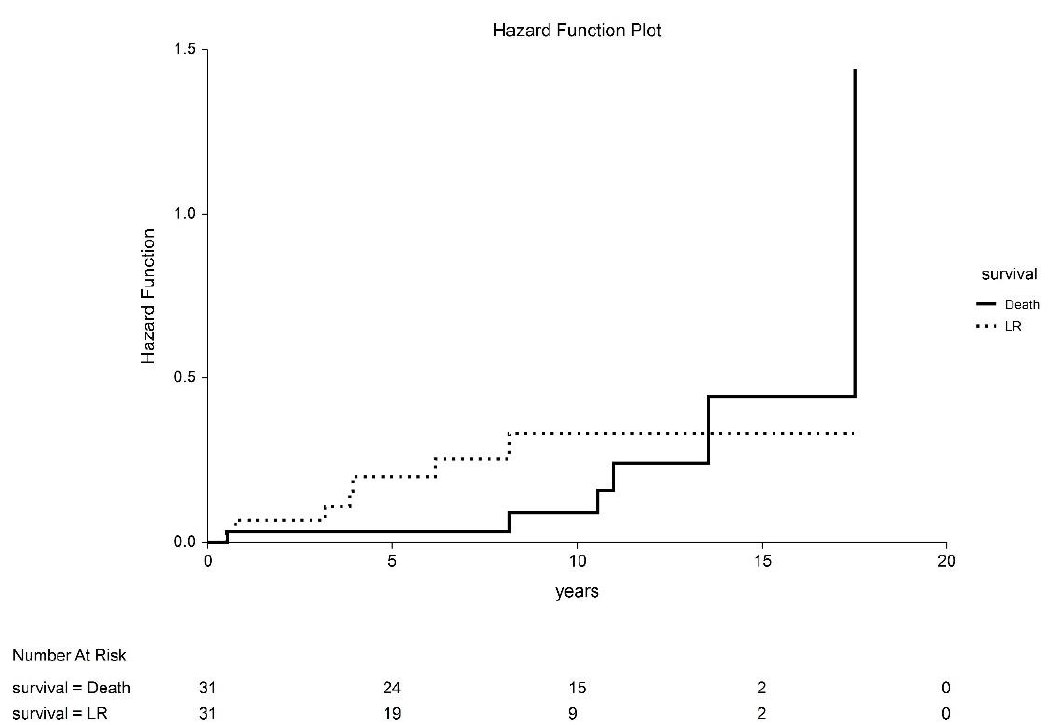
Figure 4. Competing risk analysis of deaths from other cancers.